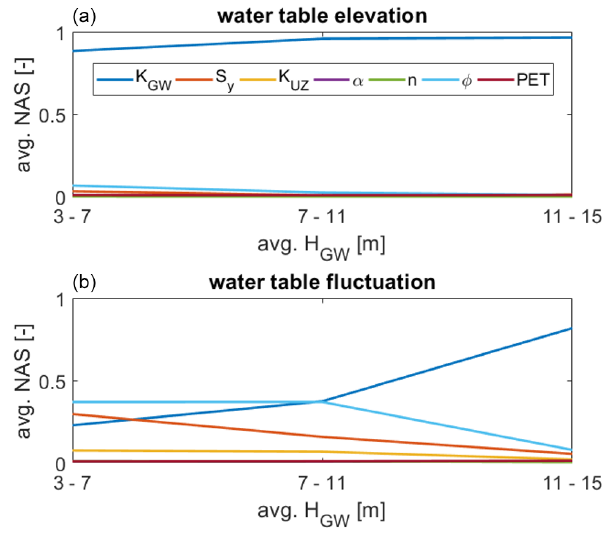
Figure 18. Averaged normalized activity scores of the last 7- year cycle over the average water table position during that pe- riod. (a) Normalized activity scores for the water table position H GW . (b) Normalized activity scores for the water table fluctuation (cid:49)H GW